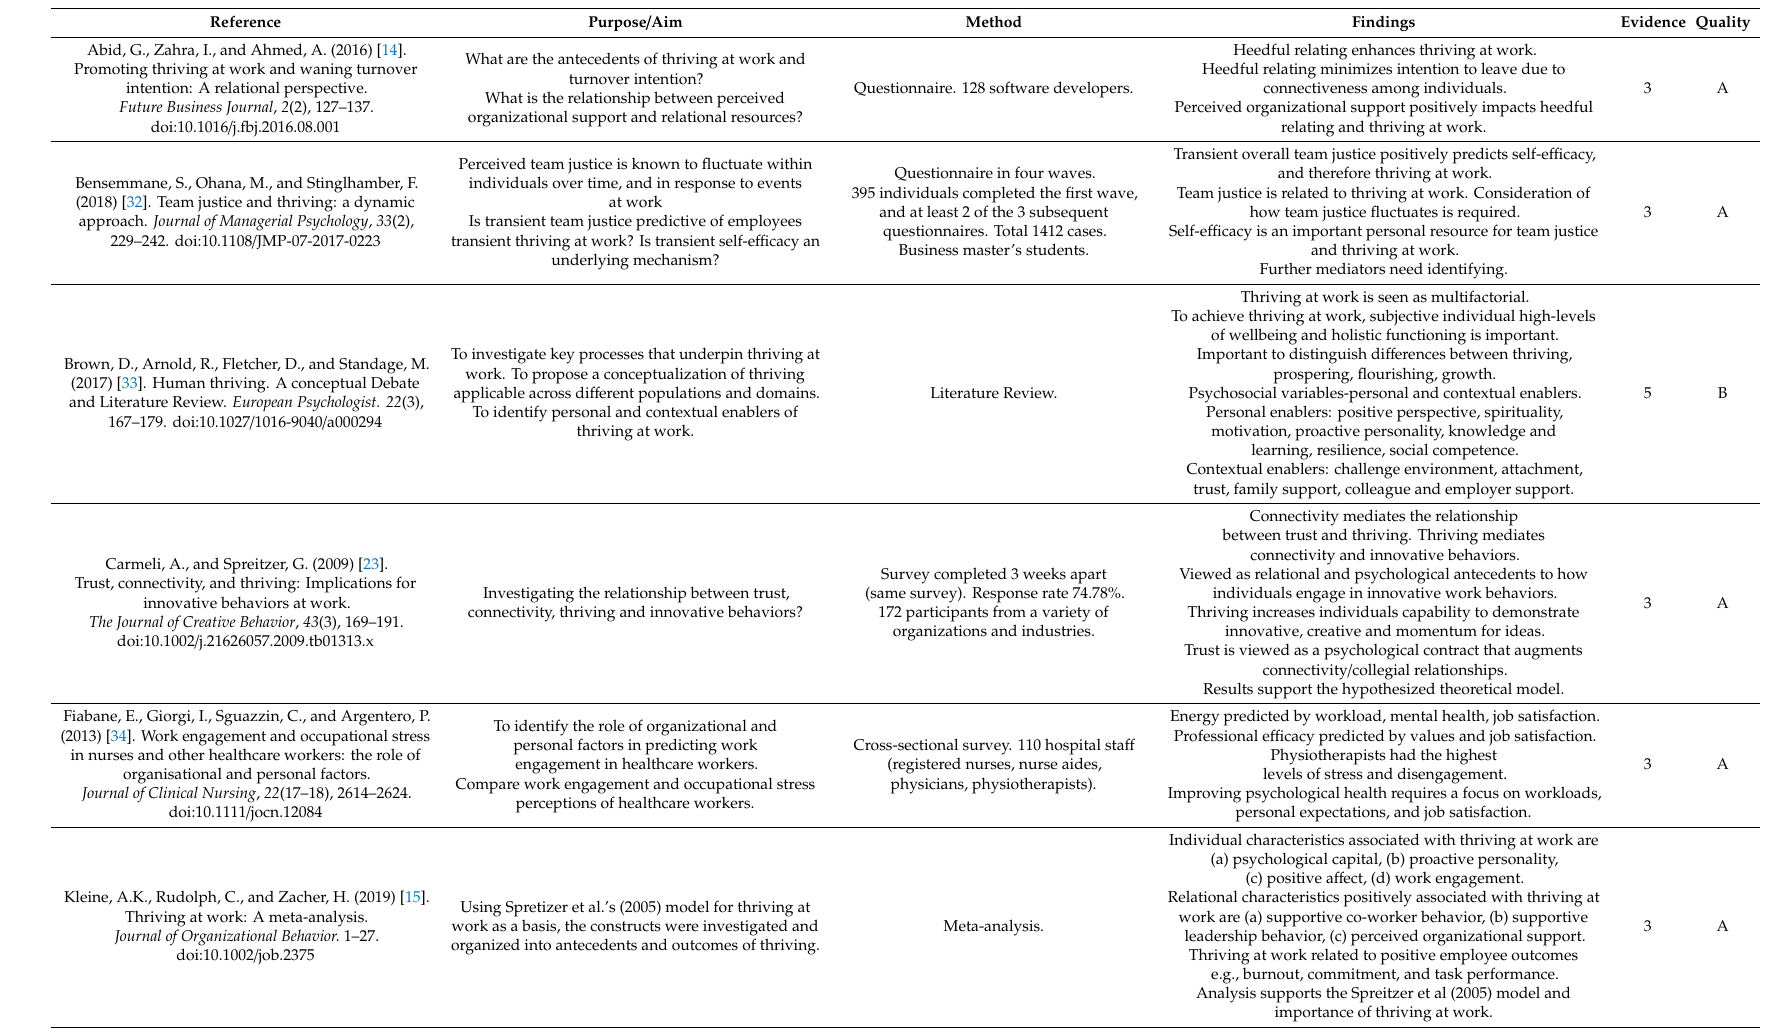
Table 2. Summary of findings from research